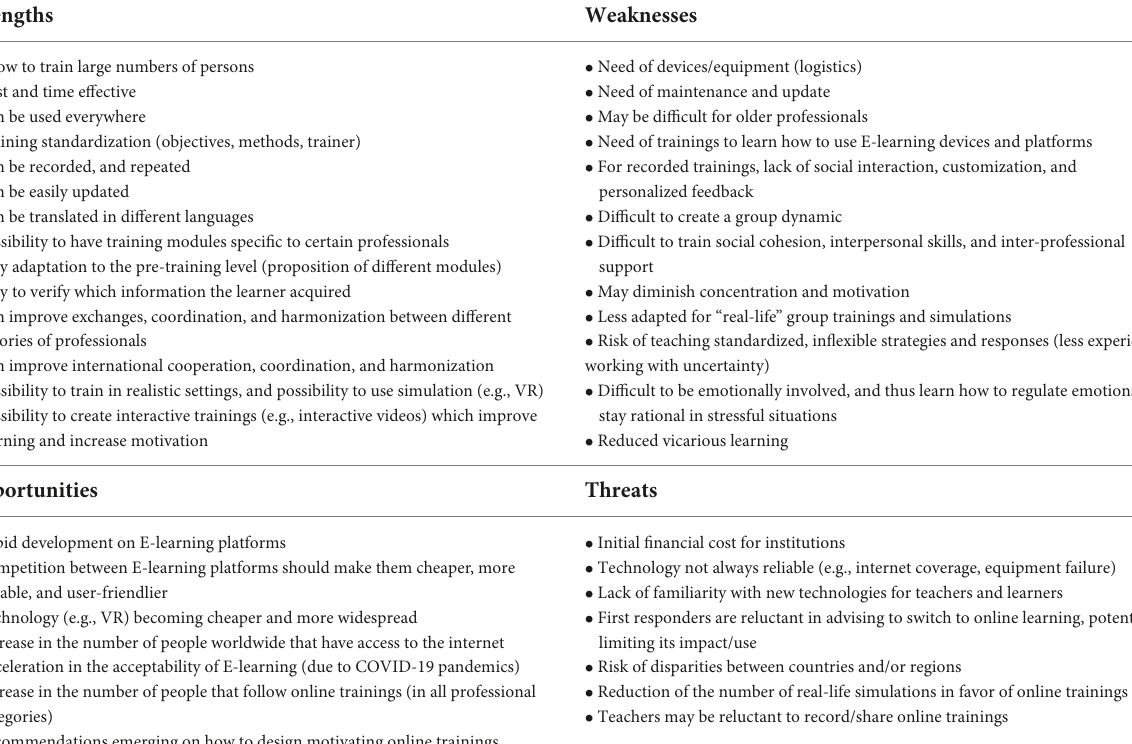
TABLE 2 Training of professionals in the acute phase: SWOT Analysis of using ICT.